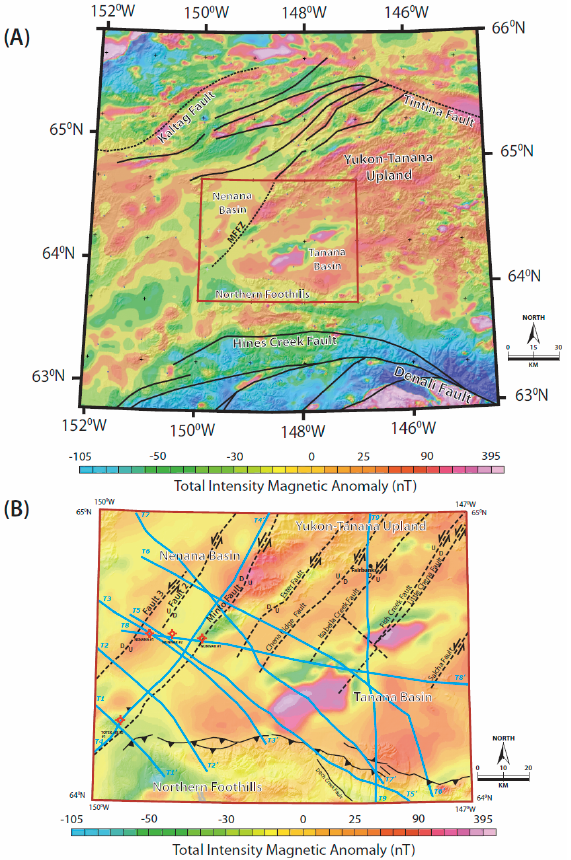
Figure 9. ( A ) The regional magnetic anomaly map. ( B ) Magnetic anomaly map of the Fairbanks quadrangle, Central Alaska. Maps are modified from Meyer [39]. Solid blue lines indicate the geophysical transects presented in our study.